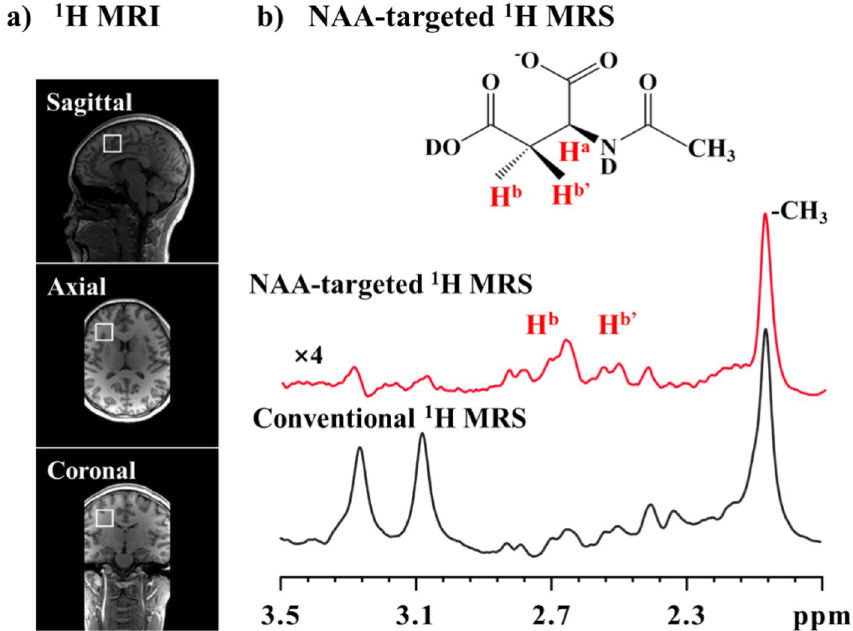
Figure 3. ( a ) Routine MRI images showing the voxel position in the human brain. The following 1 H MRS spectra were acquired in this voxel with a size of 20 × 20 × 20 mm 3 ; ( b ) the routine 1 H MRS spectrum (black) and the NAA targeted 1 H MRS spectrum (red) acquired by using SFOC-MRS-3T (see Fig. S11). The amplitude and phase of the OC pulses of NAA in the experiments are shown in the Fig. S12. The scan time of 64 scan accumulation in NAA-targeted experiments is about 3.2 min. The nutation frequency of the decoupling pulse in SFOC-MRS-3T sequence is 200 Hz (about 200 W for quadrature body RF coil) and the duration is 5 ms. More experimental details can be found in Supporting Information. The experiments were carried out on the Siemens 3T Prisma MRI scanner.